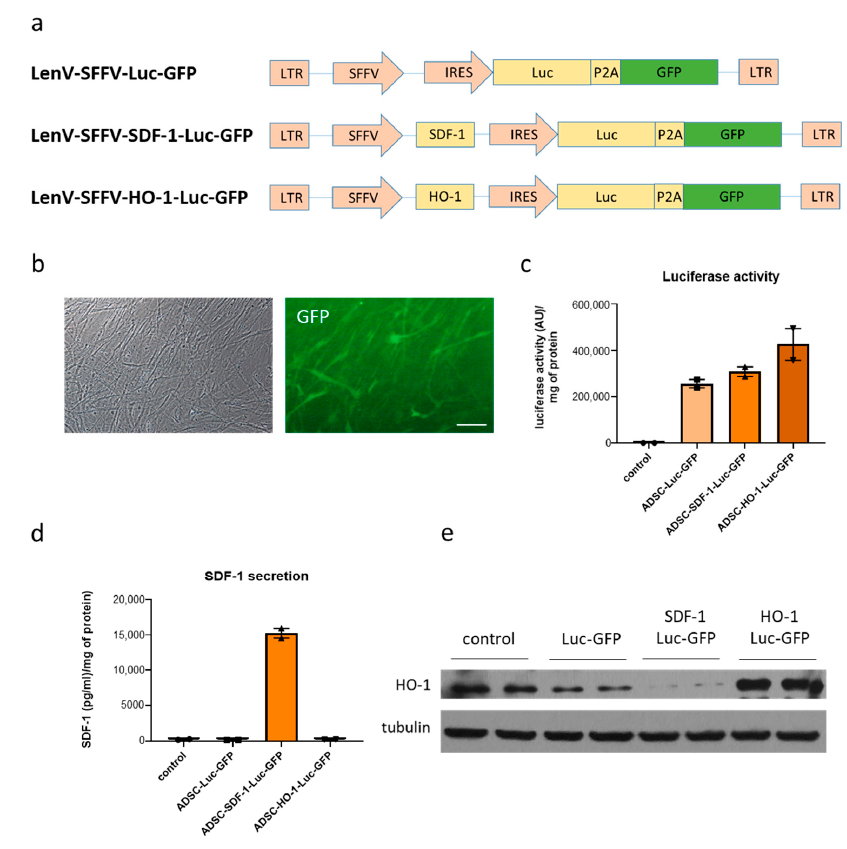
Figure 1. Generation of genetically modified adipose-derived stromal cells (ADSCs). ( a ) Schematic representation of lentiviral vectors used in the study. ( b ) GFP expression in ADSCs-Luc-GFP after cell sorting. Activity of luciferase ( c ) as well as expression of SDF-1 ( d ) and HO-1 ( e ) in transduced and purified ADSCs. Control—nontransduced ADSCs. Scale bar—50 µm.